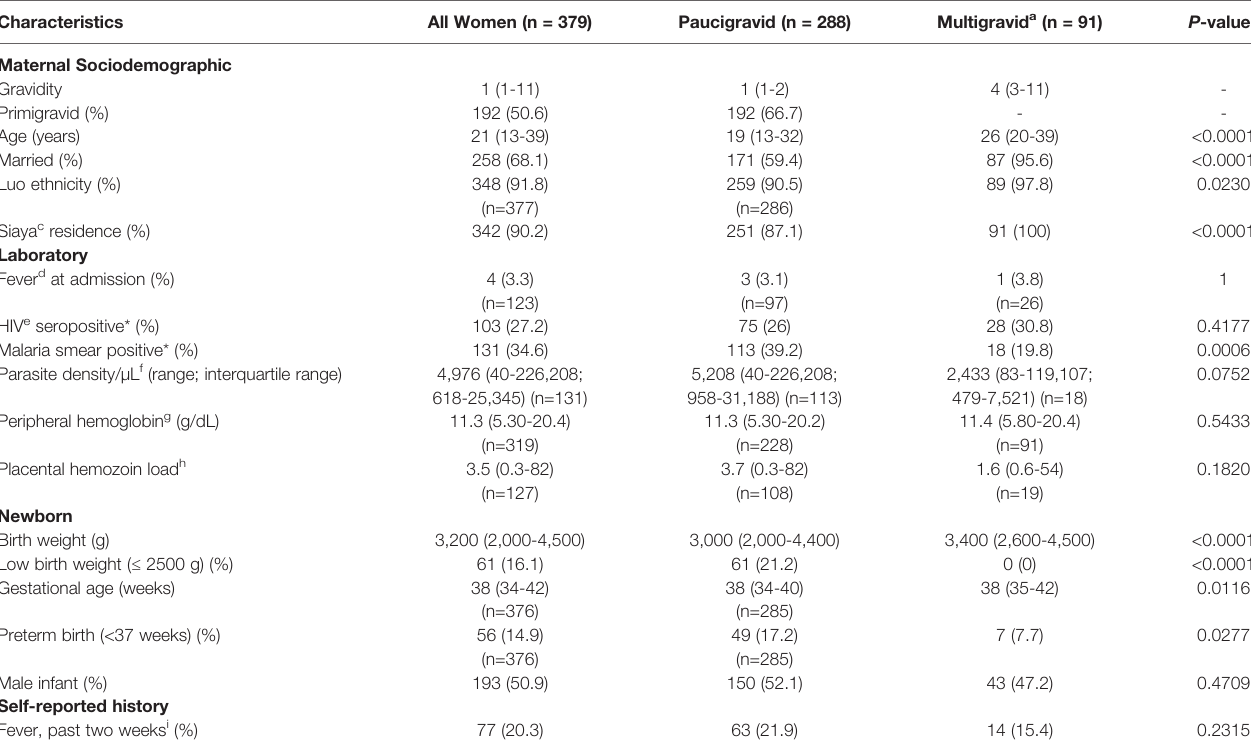
TABLE 1 | Descriptive characteristics of study population strati fi ed by gravidity.